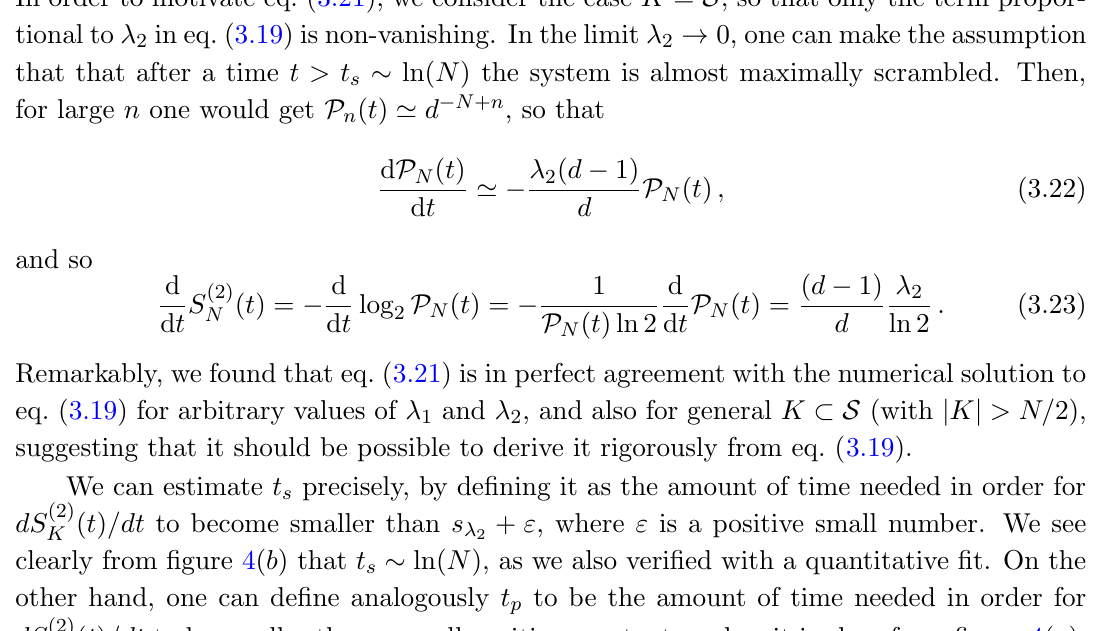
Figure 4 . Sub(cid:12)gure ( a ): time derivative of the R(cid:19)enyi-2 entropy S (2) di(cid:11)erent values of the system size N . The constant dotted line corresponds the value s (cid:21) de(cid:12)ned in eq. (3.21). Sub(cid:12)gure ( b ): same data shown in the region close to t s (cf. the main text). In both (cid:12)gures we chose (cid:20) = 3 = 4, local dimension d = 2 and (cid:21) 1 = 1, (cid:21) 2 = 1 :